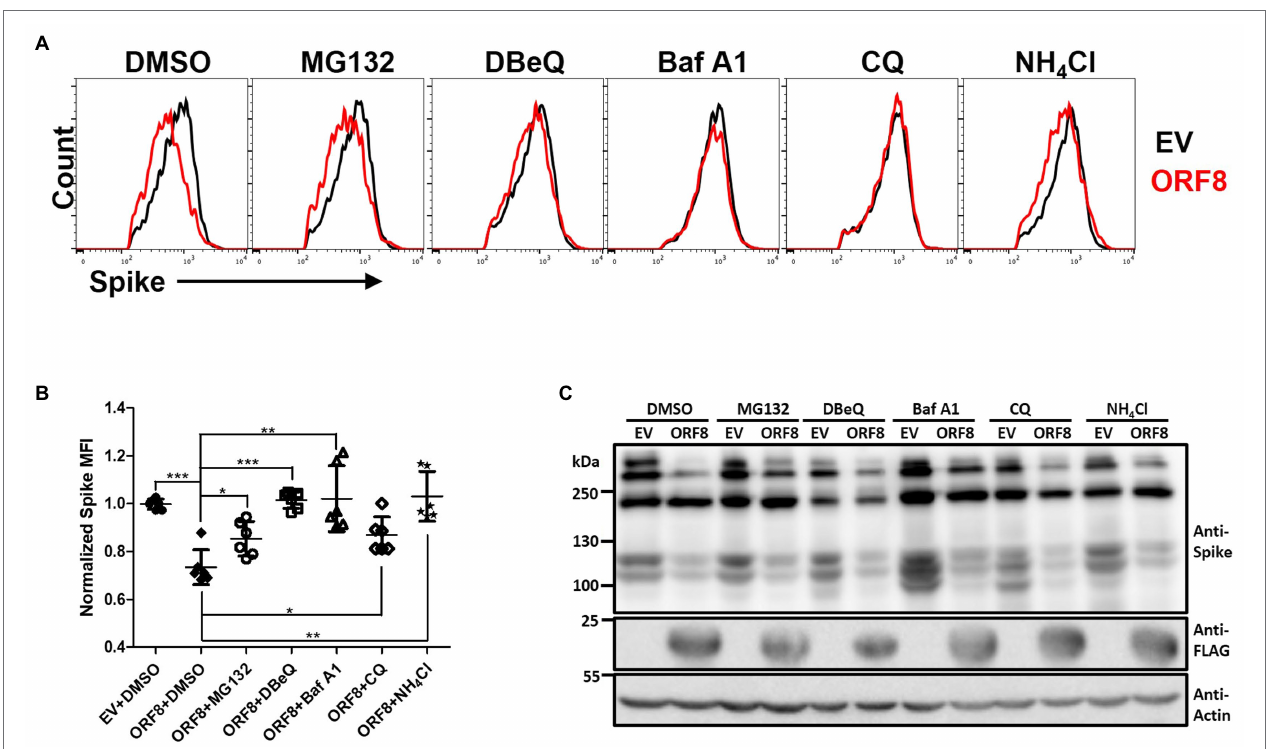
FIGURE 4 | ORF8 mediates the downregulation of the spike protein through multiple pathways. (A,B) HEK293T cells were cotransfected with the spike-encoding plasmid together with the pLAS2-ORF8-IRES-GFP (ORF8) or pLAS2-IRES-GFP (EV) plasmid at a ratio of 1–3. Forty-eight hours after transfection, the cells were treated with DMSO, MG132 (20 μ M), DBeQ (15 μ M), bafilomycin A1 (Baf A1; 200 nM), chloroquine (20 μ M), and NH 4 Cl (20 mM) for 24 h, and the cells were collected for flow cytometry using antibodies against the spike protein and HLA-A2. By using this method, we were allowed to analyze the cells with successful transfection by gating the GFP-positive cell population. Here, the results of the spike protein are shown as (A) histograms comparing EV- or ORF8-transfected cells of one experiment and (B) the scatter plot figure of the results from six-independent transfection. (C) Immunoblots of cell lysates prepared from one experiment using antibodies against the spike protein, FLAG tag, and actin. The bar figure in (B) shows the means ± SDs (error bars) and unpaired Student’s t -test was used, and p < 0.05 indicates a statistically significant difference; * p < 0.05, ** p < 0.01, *** p <